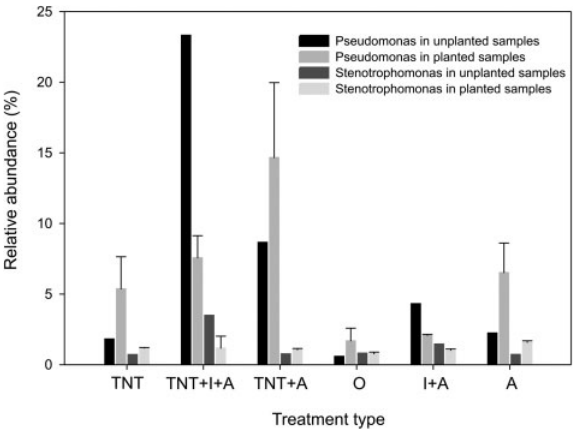
Fig. 4. Changes in relative abundance of Pseudomonas and Stenotrophomonas groups recorded by 16S rRNA gene enumerations using qPCR in samples with different treat- ments. Shown are group mean and standard deviation.